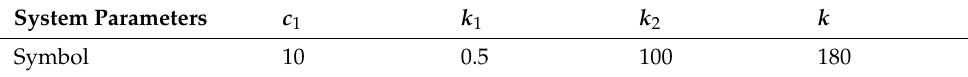
Table 3. The key parameters of the SOSMC based on singular perturbation strategy.